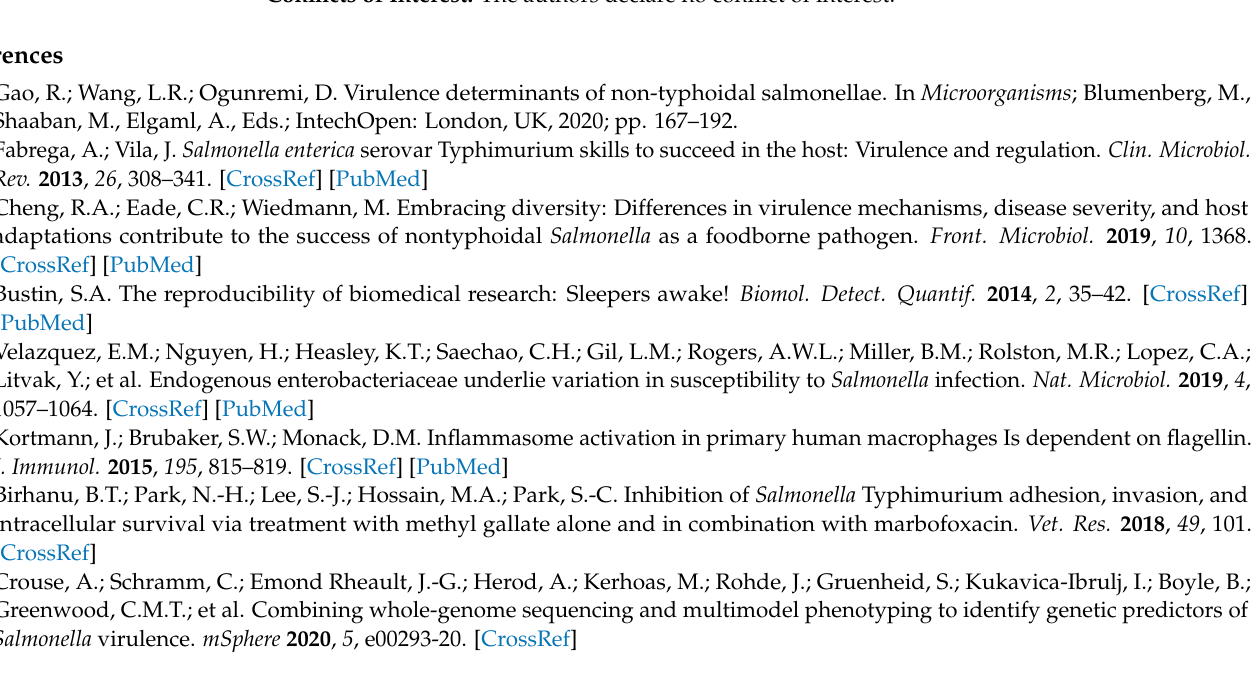
Table S1: List of all 1200 primers used in the designed AmpliSeqSalm_227VG panel. Table S2: List of 16,729 amplicons including size, start/stop locations of in silico generated amplicons used for the designed AmpliSeqSalm_227VG panel. Table S3: List of variants of virulence genes detected among 29 out of 35 Salmonella enterica strains bioinformatically assigned to the correct serovar. Table S4: Presence and absence of the 227 virulence genes among all the tested 69 Salmonella strains. Table S5: Variants of the virulence genes found in 10 Salmonella Typhimurium strains used for an infection experiment based on No. 8_ST07-22495 as